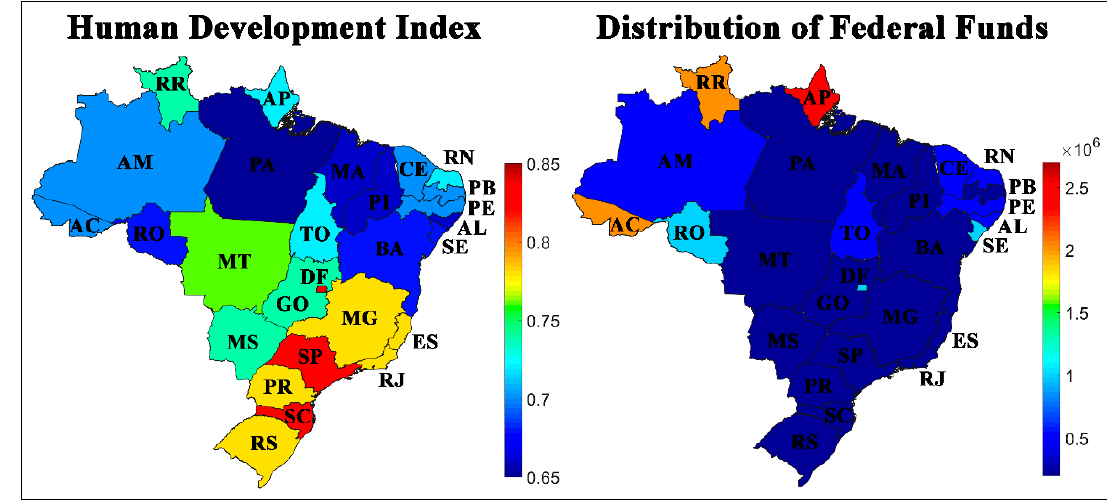
Figure 6. Geographical distribution by Index Development Index (HDI) and Federal funds destined to combat COVID-19 in Brazilian states per 100,000 inhabitants.